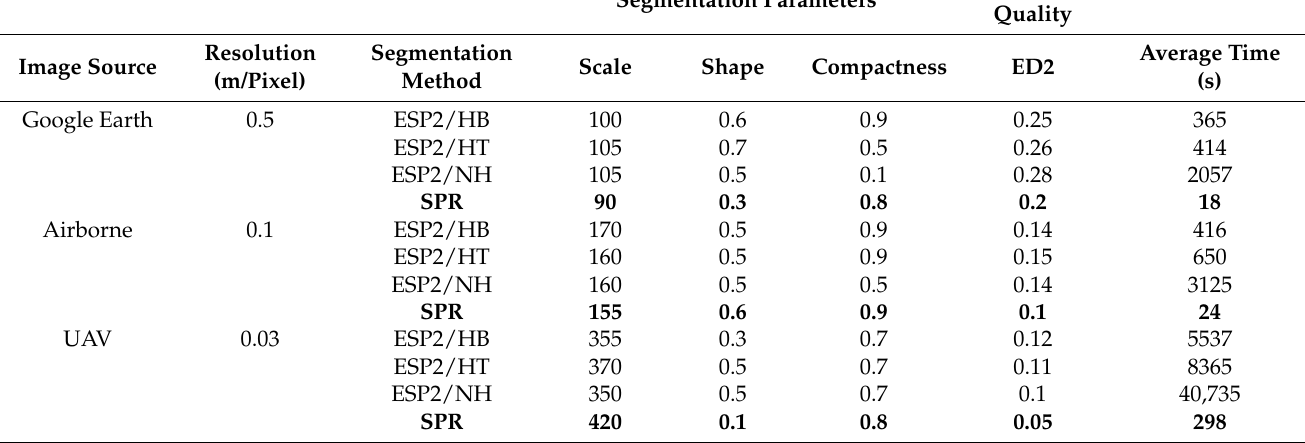
Table 1. Segmentation accuracies of Object-Based Image Analysis (OBIA) among the three spatial resolutions evaluated. For each segmentation type, only the most accurate combination of Scale, Shape, and Compactness is shown. ESP2/HB: Estimate Scale Parameter v.2 (ESP2) with Bottom-up Hierarchy; ESP2/HT: ESP2 with Top-down Hierarchy; ESP2/NH: ESP2 Non-Hierarchical; SPR: Segmentation with Parameters Range. Closer values to 0 indicate accurate segmentations. In bold the most accurate